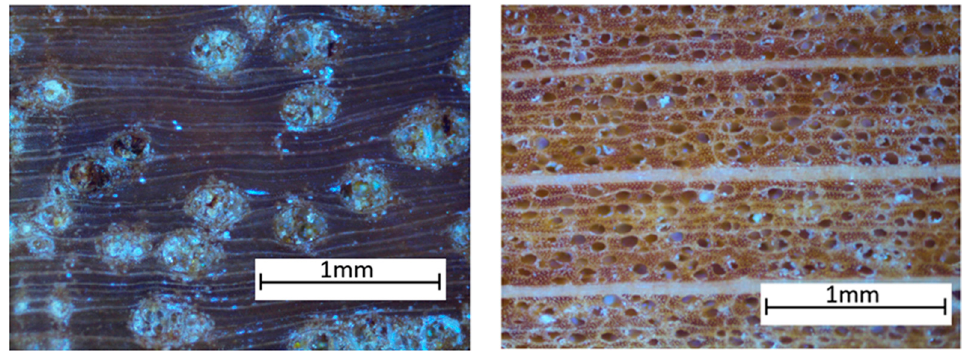
Figure 2. Contrasting wood structures (cross-sections) at 50× magnification of spotted gum ( left ) and European beech ( right ).